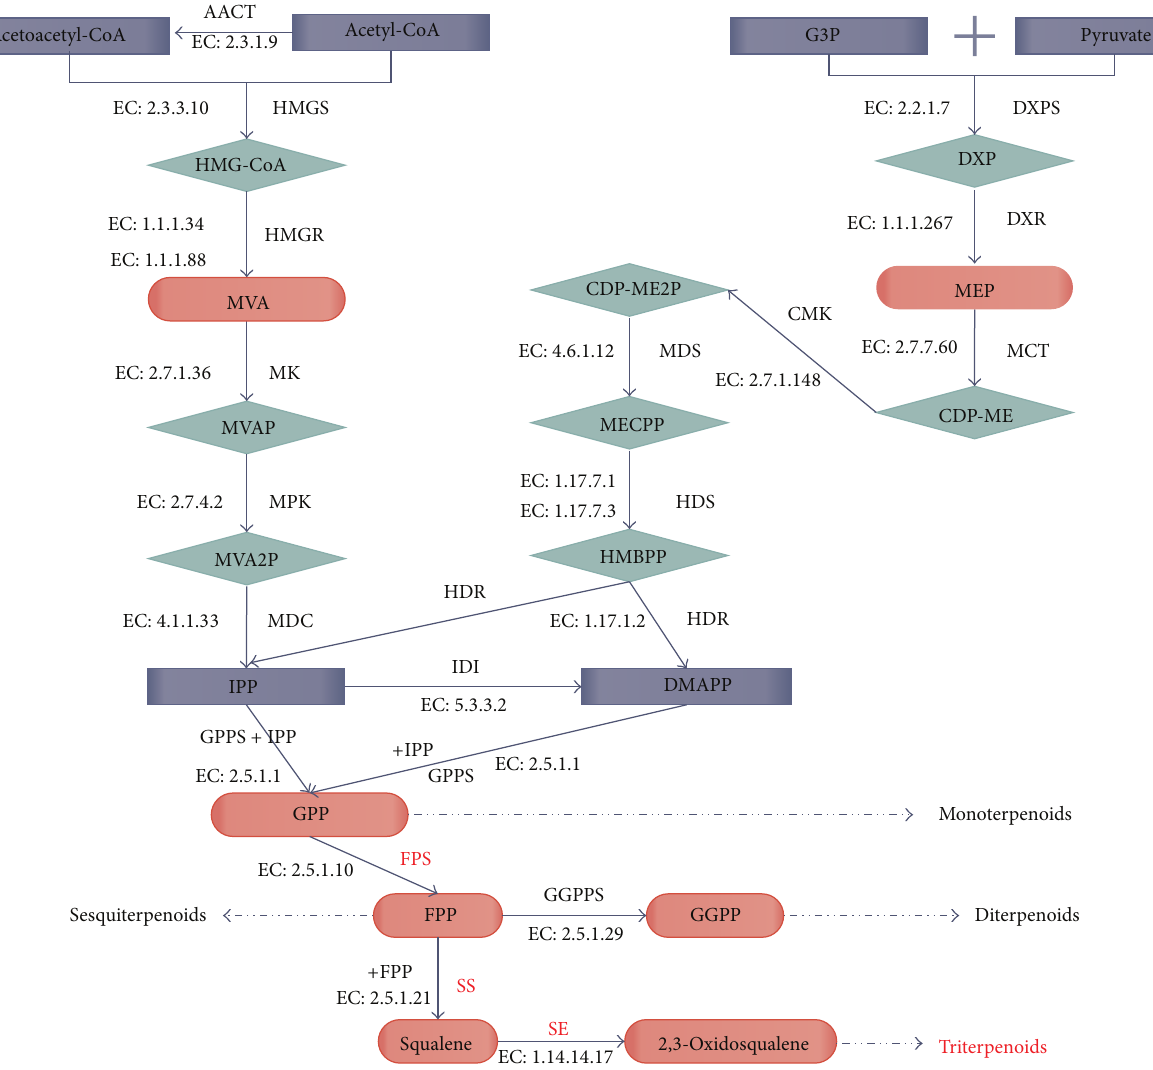
Figure 1: Triterpenoid synthesis pathway. Note: AACT: acetyl-CoA C-acetyltransferase; HMGS: hydroxymethylglutaryl-CoA